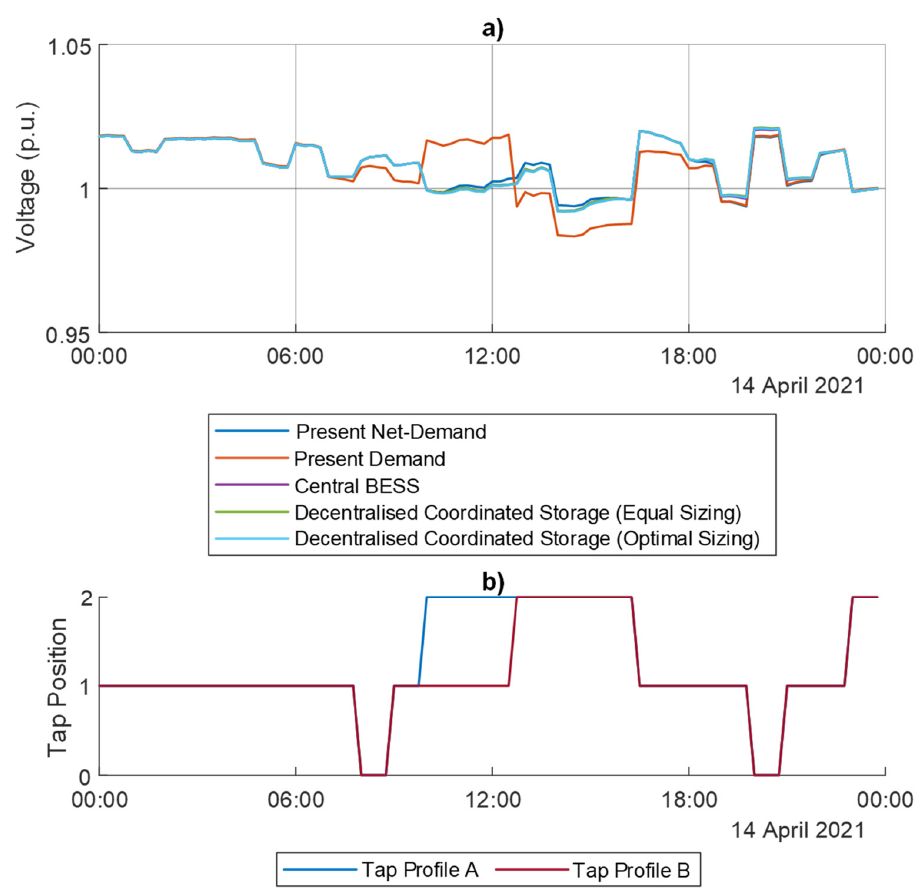
Figure 10. ( a ) Simulated voltage profiles at the 11 kV side of the Xewkija DC transformer. ( b ) Tap positions for simulations. Profile B is for the Case 2 (Demand) while Profile A was common to the other four scenarios.